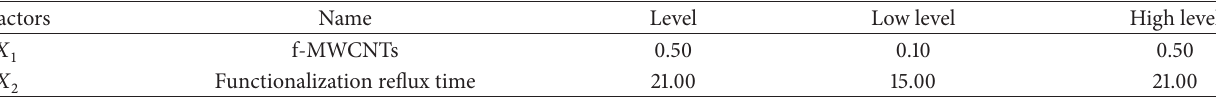
Table 8: Optimization results for design factors of UF-MWCNTs fertilizer.